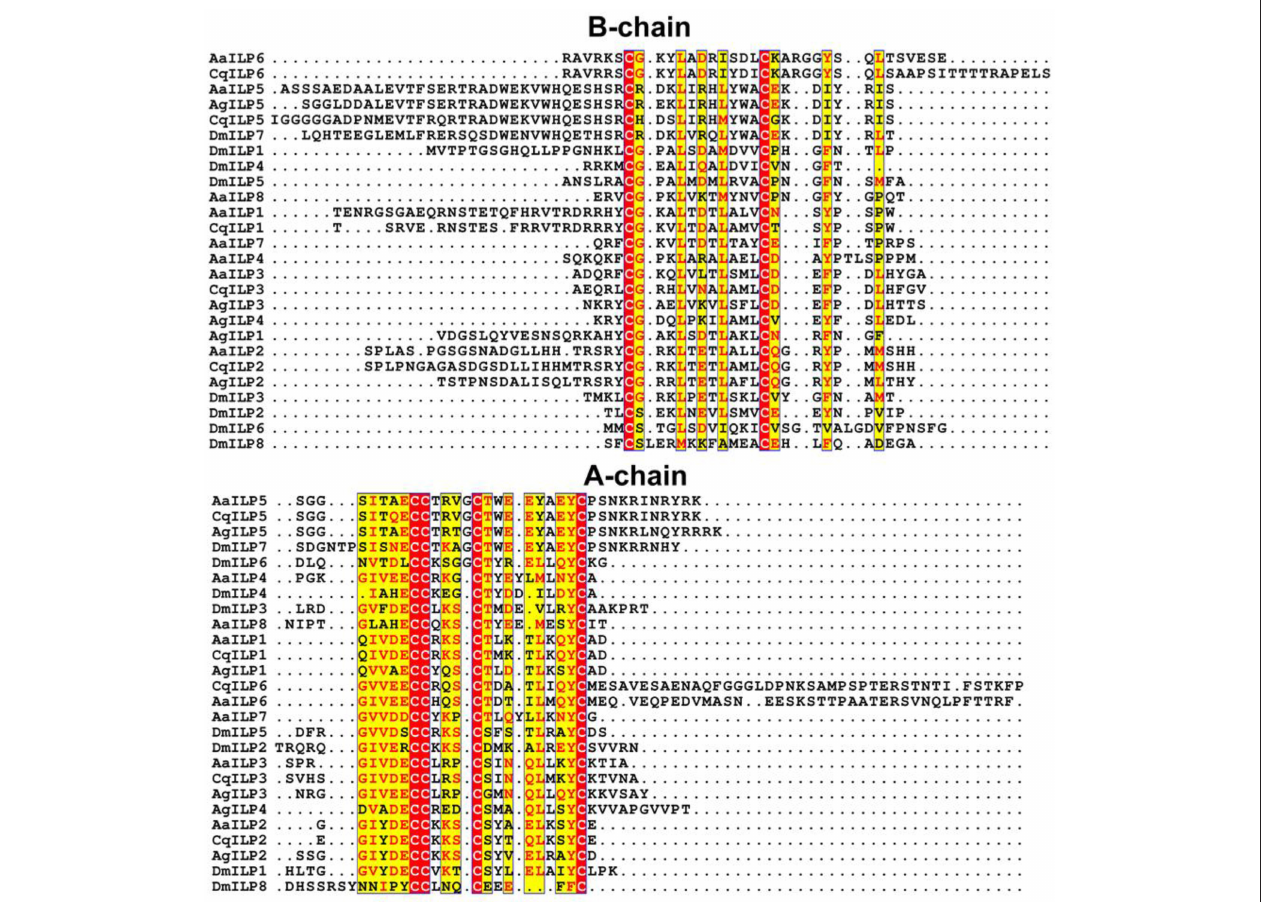
FIGURE 1 | Alignment of mosquito ILP amino acid sequences comparing Ae. aegypti (Aa), C. quinquefasciatus (Cq), A. gambiae (Ag), and D. melanogaster (Dm) ILPs by B- or A-chain. Red highlights indicate all identical residues, yellow highlights indicate majority conserved residues (red text indicates conserved residues, black indicates variants). The exceptionally long predicted A-chain of C. quinquefasciatus ILP6 is truncated at Pro146 for the sake of space. Alignments were performed in Pôle Rhône-Alpes de Bioinformatique (PRABI) website (32) and ESPript 3.0